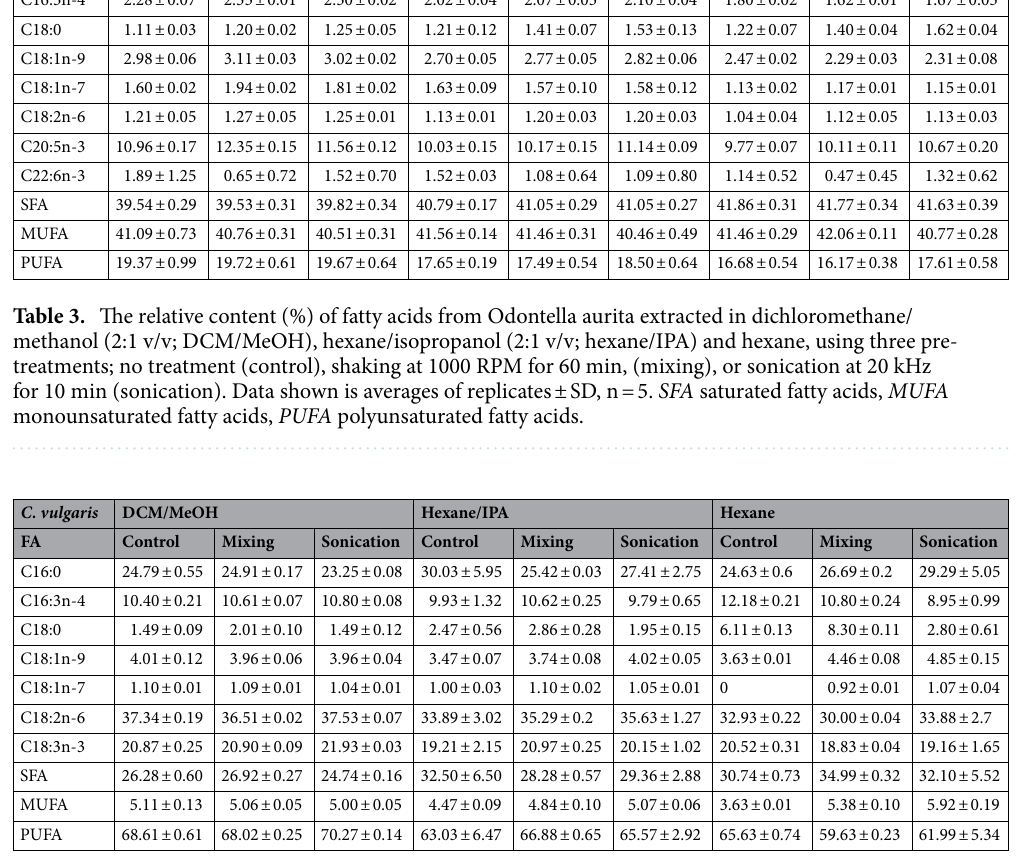
Table 4. The relative content (%) of fatty acids from Chlorella vulgaris extracted in dichloromethane/ methanol (2:1 v/v; DCM/MeOH), hexane/isopropanol (2:1 v/v; hexane/IPA) and hexane, using three pre- treatments; no treatment (control), shaking at 1000 RPM for 60 min, (mixing), or sonication at 20 kHz for 10 min (sonication). Data shown is averages of replicates ± SD, n = 5. SFA saturated fatty acids, MUFA monounsaturated fatty acids, PUFA polyunsaturated fatty